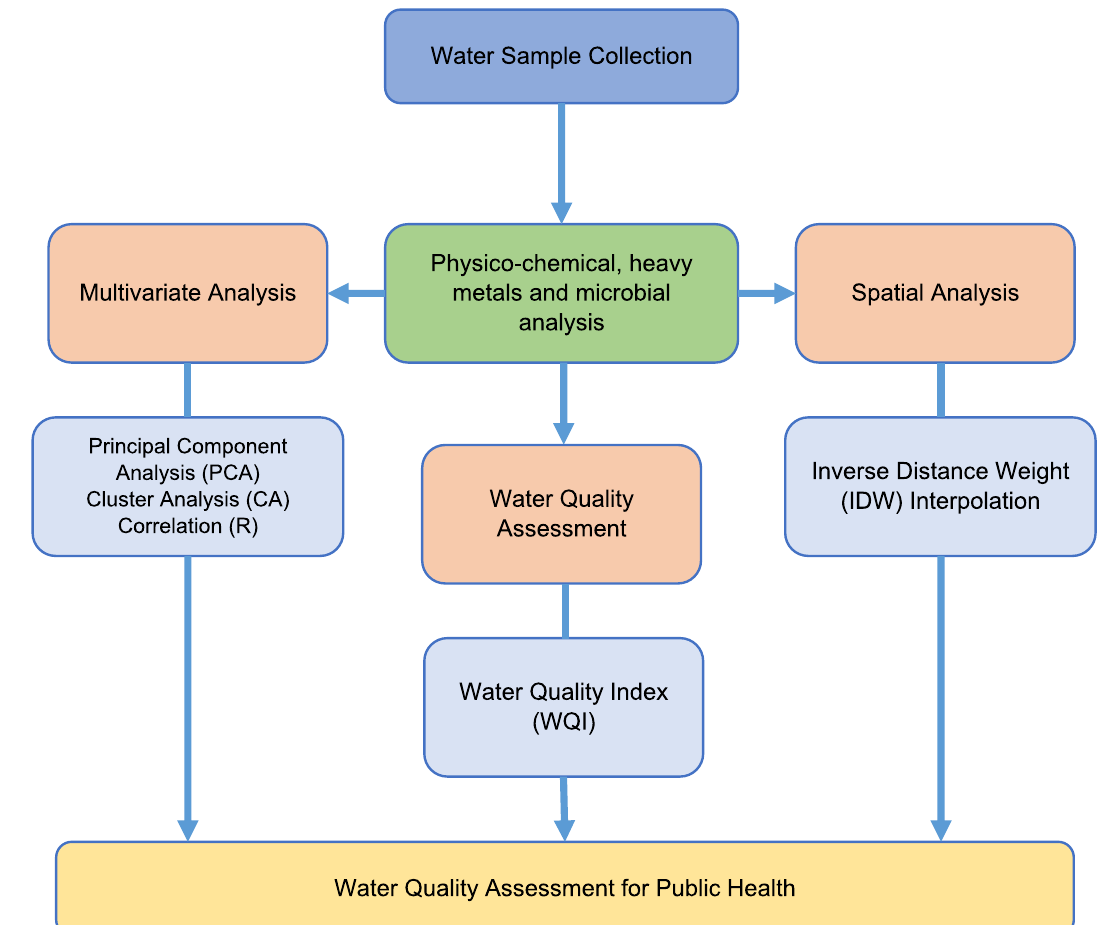
Fig. 2 Work Flow